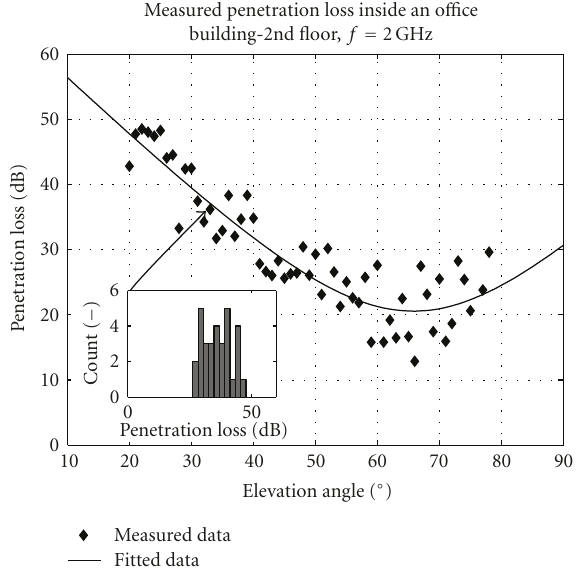
Figure 4: Penetration loss as a function of the elevation angle on the second floor of an o ffi ce building at 2.0